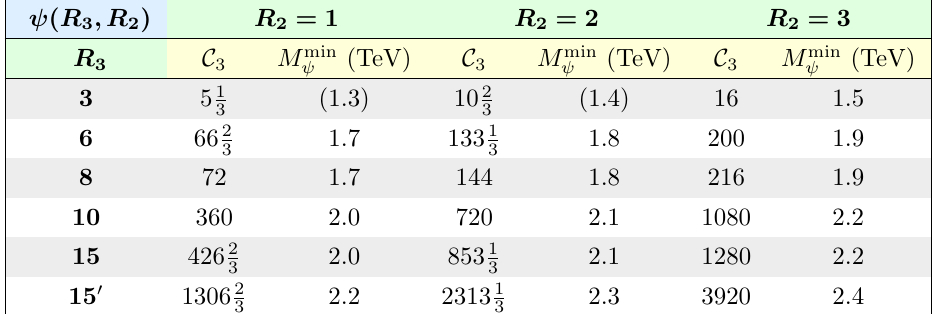
Table 8 . Lower limits on the mass of the lightest BSM fermion, M min , as derived from the searches for long-lived charged particle by CMS [35, 37] and ATLAS [36] for N F = 1. We make explicit a dependence on the fermion representations R 2 and R 3 under SU(2) L and SU(3) C , respectively. The dominant contribution to the production cross section is proportional to C 3 , (5.6), which is also given. Values in parentheses correspond to scenarios ( R 3 ; R 2 ) with no weakly interacting UV (cid:12)xed points, see (cid:12)gure